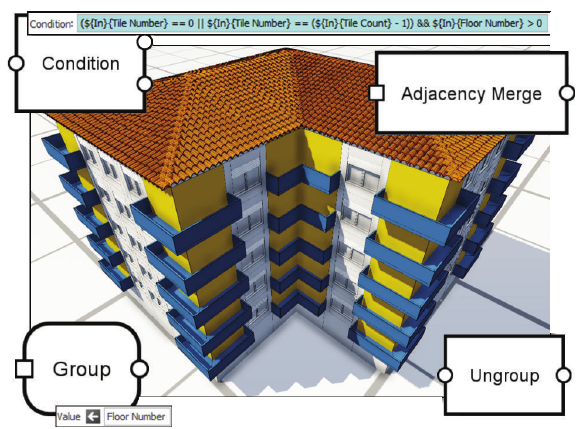
Figure 6: Building featuring balconies that stretch across fac¸ade corners, an example that cannot be naturally achieved using shape